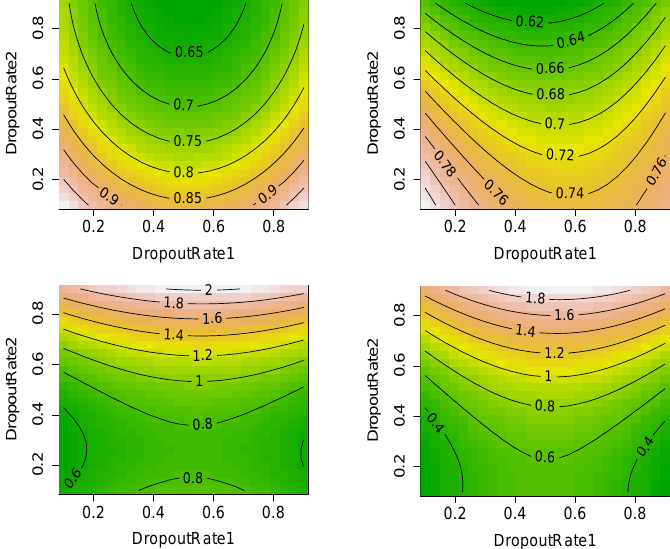
Figure A2. RSM are illustrated on the first row for validation and test classification accuracy, when tuning values for the dropout rates. The bottom plots show the corresponding RSM for loss